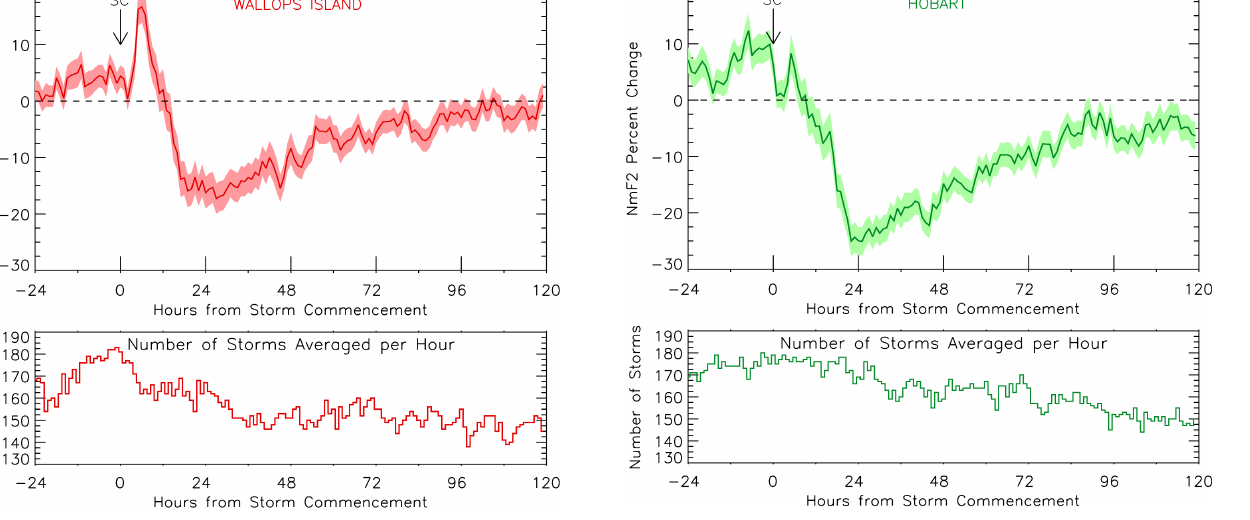
Fig. 3. Average storm-time patterns for 1 Nm F2 ( τ , %) at Wal- lops Island. The shading gives the error of the mean (see text) at each storm-time hour. The lower panel gives the number of storms (from the total of 206 possible) used to form the pattern given. To illustrate the difference between the standard deviation ( σ) and the error of the mean ( σ M ) , σ =± 35.94% at the peak of the positive phase ( τ =6h), and σ =± 33.98% at the peak of the negative phase ( τ =27h). At these times, σ M =± 2.82% and ± 2.68%, respectively.